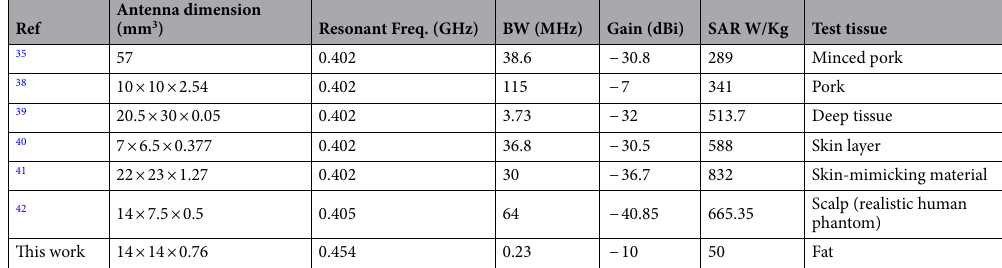
Table 1. Performance comparison between the proposed antenna and the relevant